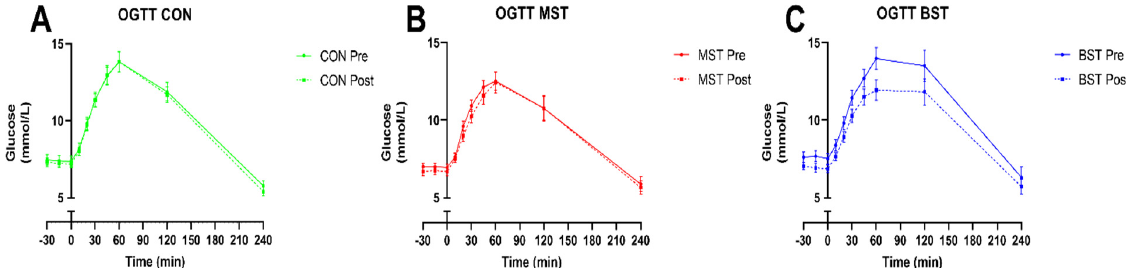
Table 3. Changes ( Δ ) in fasting insulin, glucagon, and area under the curve (AUC) from the Oral Glucose Tolerance Test Figure 4. OGTT before and after 12-weeks of intervention. ( A ) CON, ( B ) MST, ( C ) BST. Data are presented as mean ( ± SEM). regarding insulin (240 min), glucagon (240 min), and HOMA-IR calculations. Figure 4. OGTT before and after 12-weeks of intervention. ( A ) CON, ( B ) MST, ( C ) BST. Data are presented as mean (±SEM). Significance testing was performed on between group differences in change in iAUC OGTT glucose (please see Figure 3A). Significance testing was performed on between group differences in change in iAUC OGTT glucose (please see Figure 3A). Table 3. Changes ( ∆ ) in fasting insulin, glucagon, and area under the curve (AUC) from the Oral Glucose Tolerance Test regarding insulin (240 min), glucagon (240 min), and HOMA-IR calculations.